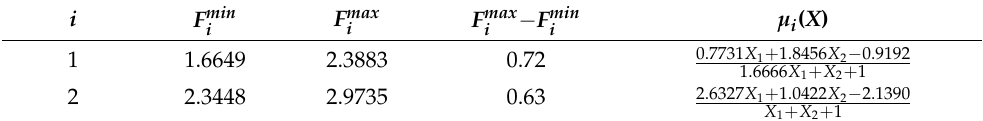
Table 5. Maxima and minima of F i ( X ) over feasible region S and the membership functions for (23).